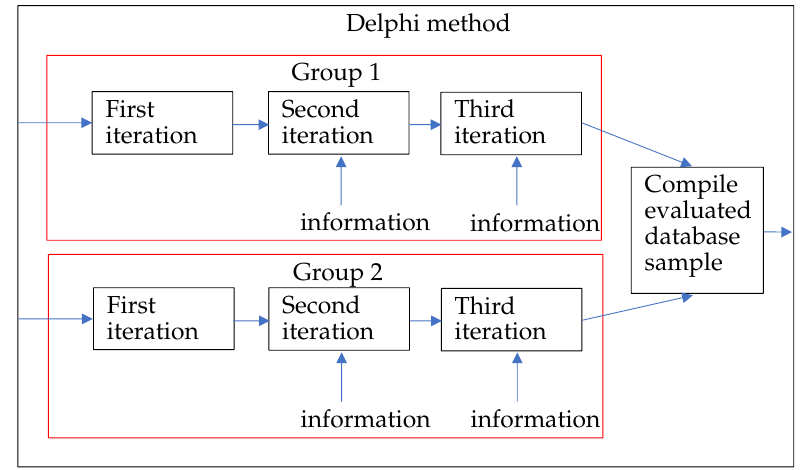
Figure 3. Implementation of Delphi method.